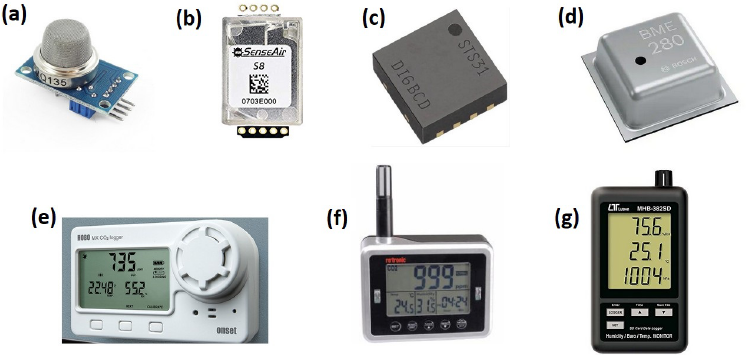
Figure 1. Environmental sensors used for collecting occupancy-related information. ( a ) CO 2 sensor MQ135. ( b ) CO 2 sensor SenseAir S8. ( c ) Temperature sensor SENSIRION STS31. ( d ) Temperature, RH, Pressure sensor BME280. ( e ) CO 2 sensor HOBO MX1102. ( f ) CO 2 , temperature and RH sensor CL11. ( g ) Barometric pressure sensor